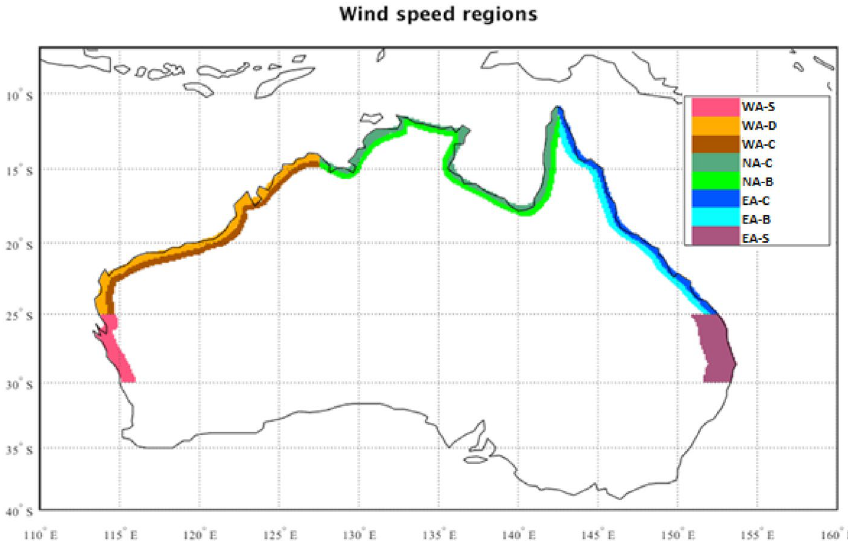
Figure 1. Wind speed regions used in this study. These regions have been designated by the historical wind strength the region has experienced (AS/NZS 1170.2:2021). Considering the strongest designation in each of our regions, in descending order of strength these correspond to: Region D (WA-D), Region C (WA-C, WA-S, NA-C and EA-C) and Region B (NA-B, EA-B and